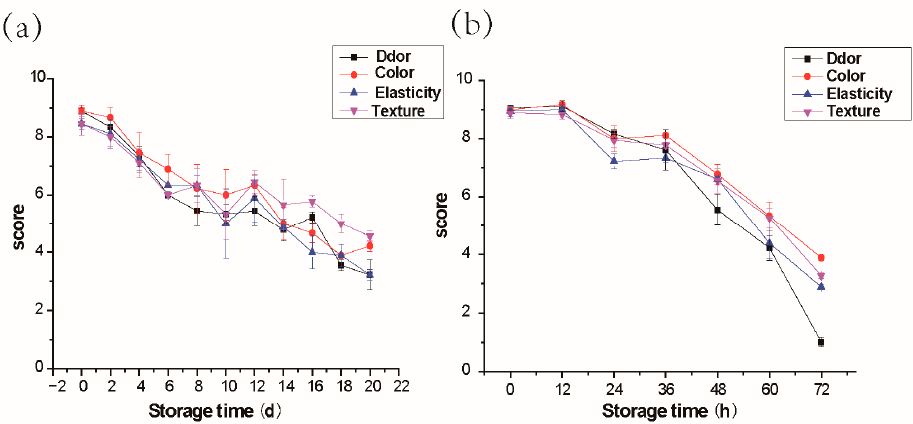
Figure 1. Changes of sensory in salmon stored at 4 °C ( a ) and 25 °C ( b ). Error bars are representative of mean ± standard error.